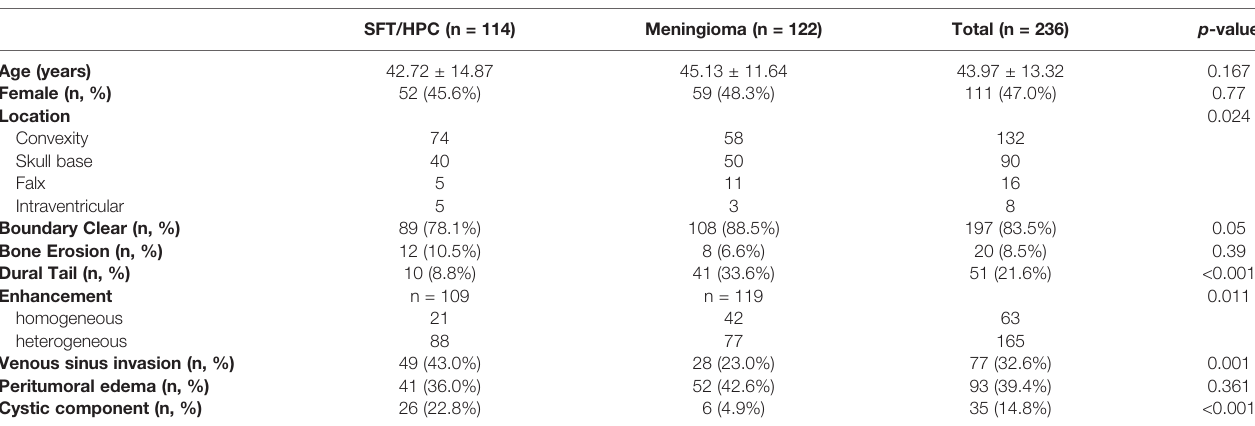
TABLE 2 | Demographic